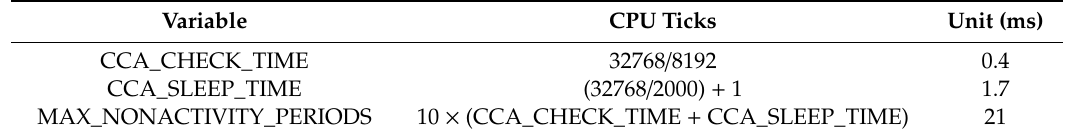
Table 4. Amount of e ff ect on idle listenings and false WakeUps according to ContikiMAC.c.